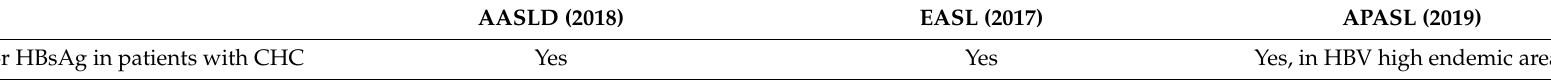
Table 2. International guidelines for management of HBV reactivation in HCV / HBV co-infected patients receiving DAA therapy for chronic hepatitis C.